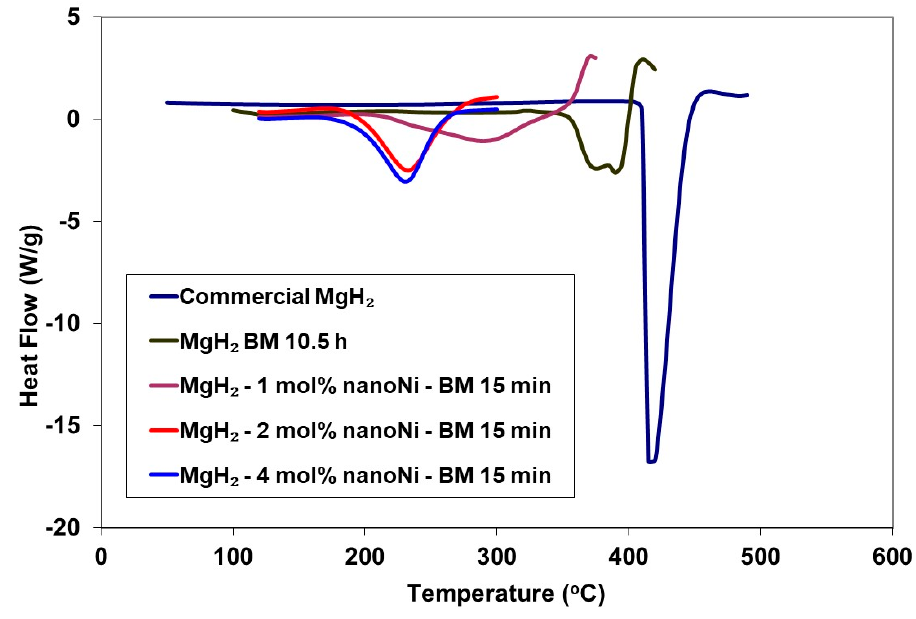
Figure 3. Differential scanning calorimetric (DSC) profiles of commercial MgH 2 , 10.5 h ball milled (BM) micro/nanocrystalline MgH 2 , and micro/nanocrystalline MgH 2 doped with nano-Ni catalysts at different mole concentrations and ball milled for additional 15 min. Table 2. Hydrogen desorption reaction enthalpy ( Δ H dec ) of commercial bulk MgH 2 , nanocrystalline MgH 2 prepared by ball milling for 9-12 h, and 2 mol% nano-Ni doped nanoMgH 2 .